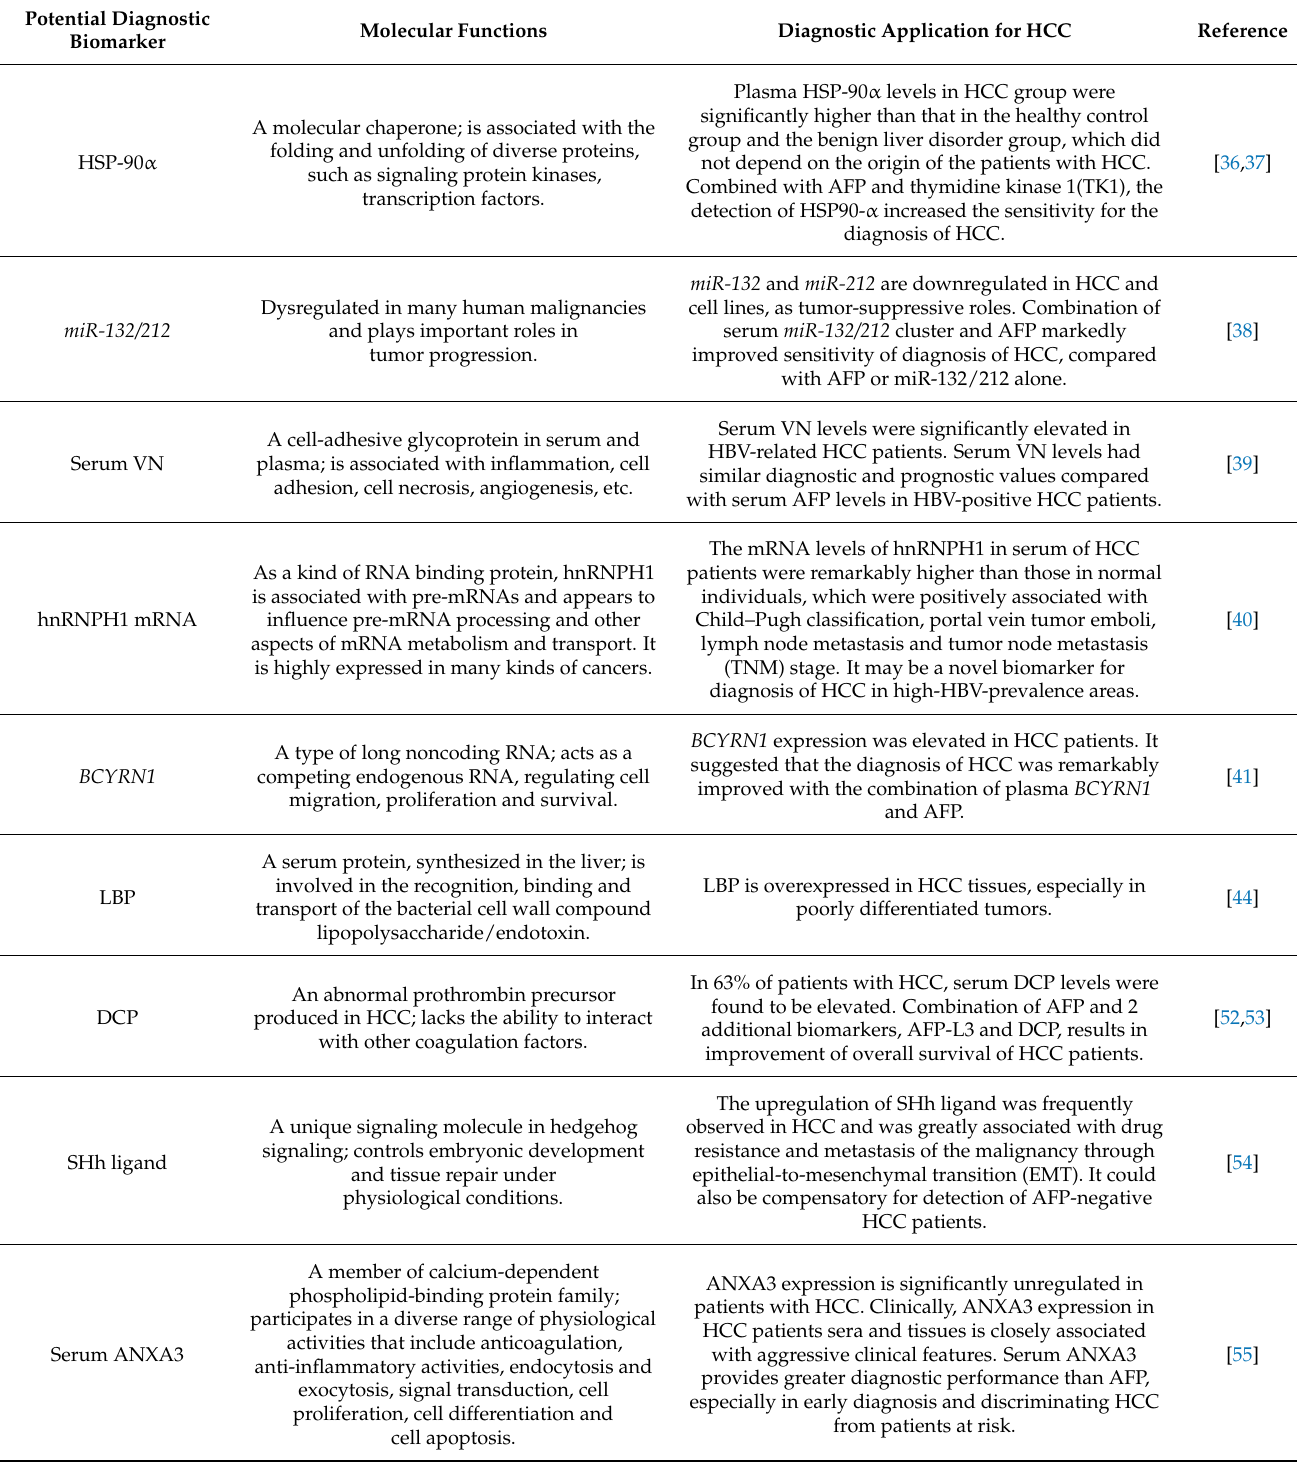
Table 1. Potential diagnostic biomarkers and their influences on